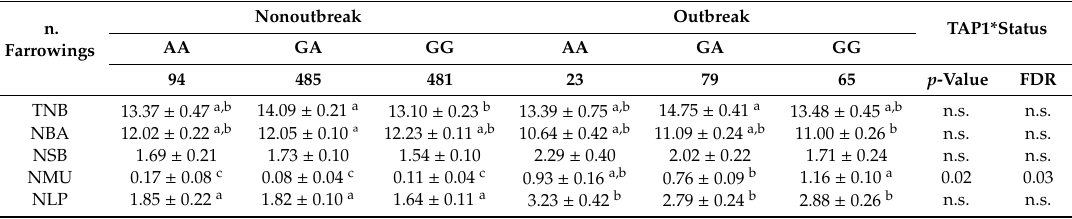
Table 4. Least square means ( ± SE) for reproductive traits by TAP1_rs1109026889 genotype and farm health status. Significant interactions between genotype and the health status of the farm (TAP1*Status) are indicated.